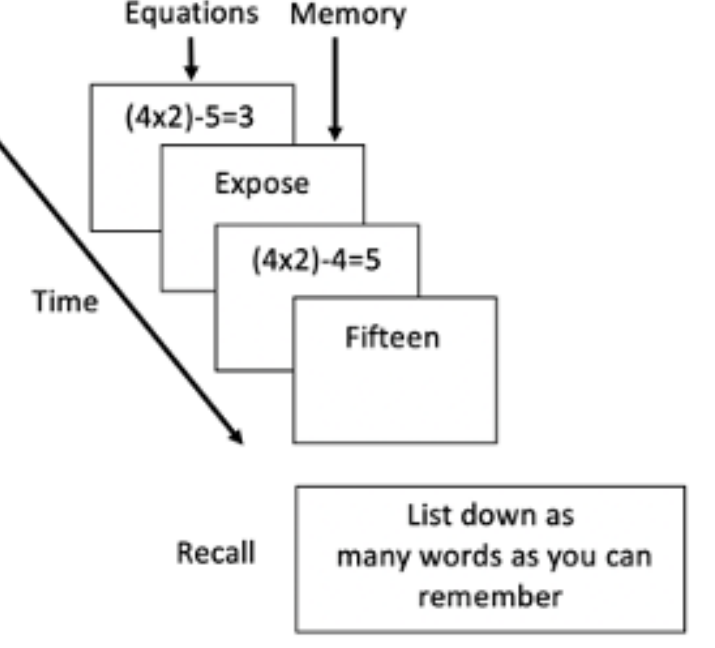
Figure 1. Operation Span Task.